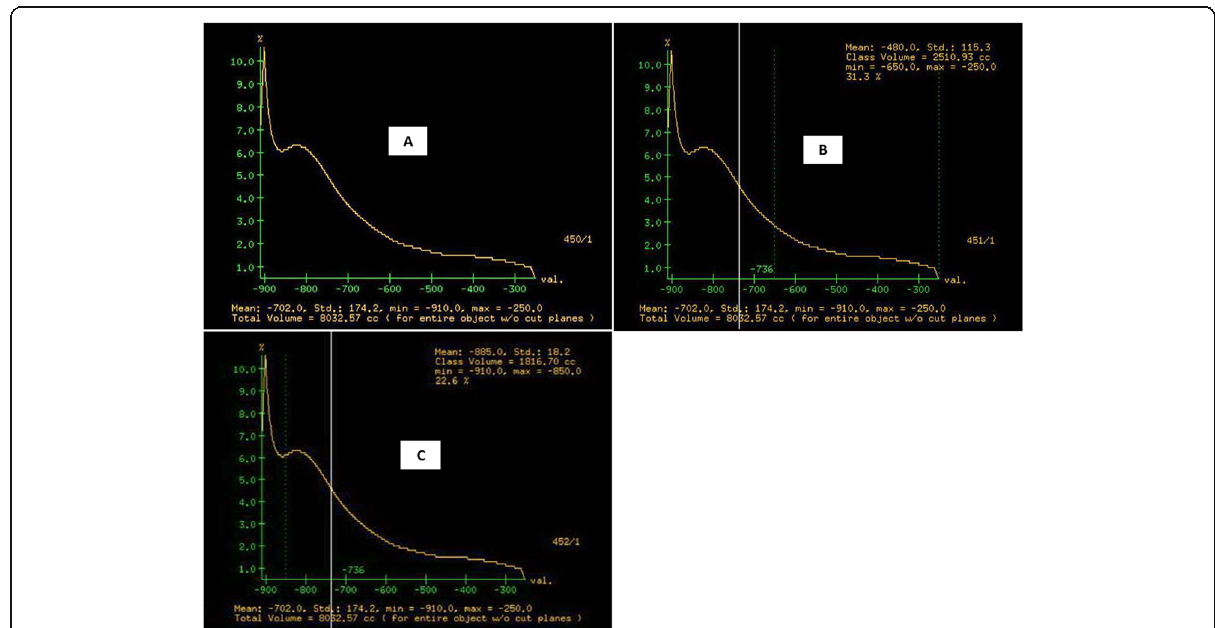
Fig. 3 CT histogram analysis a showing total lung volume (TLV) and mean lung density (MLD) between threshold densities − 250 and − 910HU, b showing the percentage of the lung occupied by high attenuation areas (HAAs %) about 31.3%, and c showing the percentage of the lung occupied by low attenuation areas (LAAs %) about